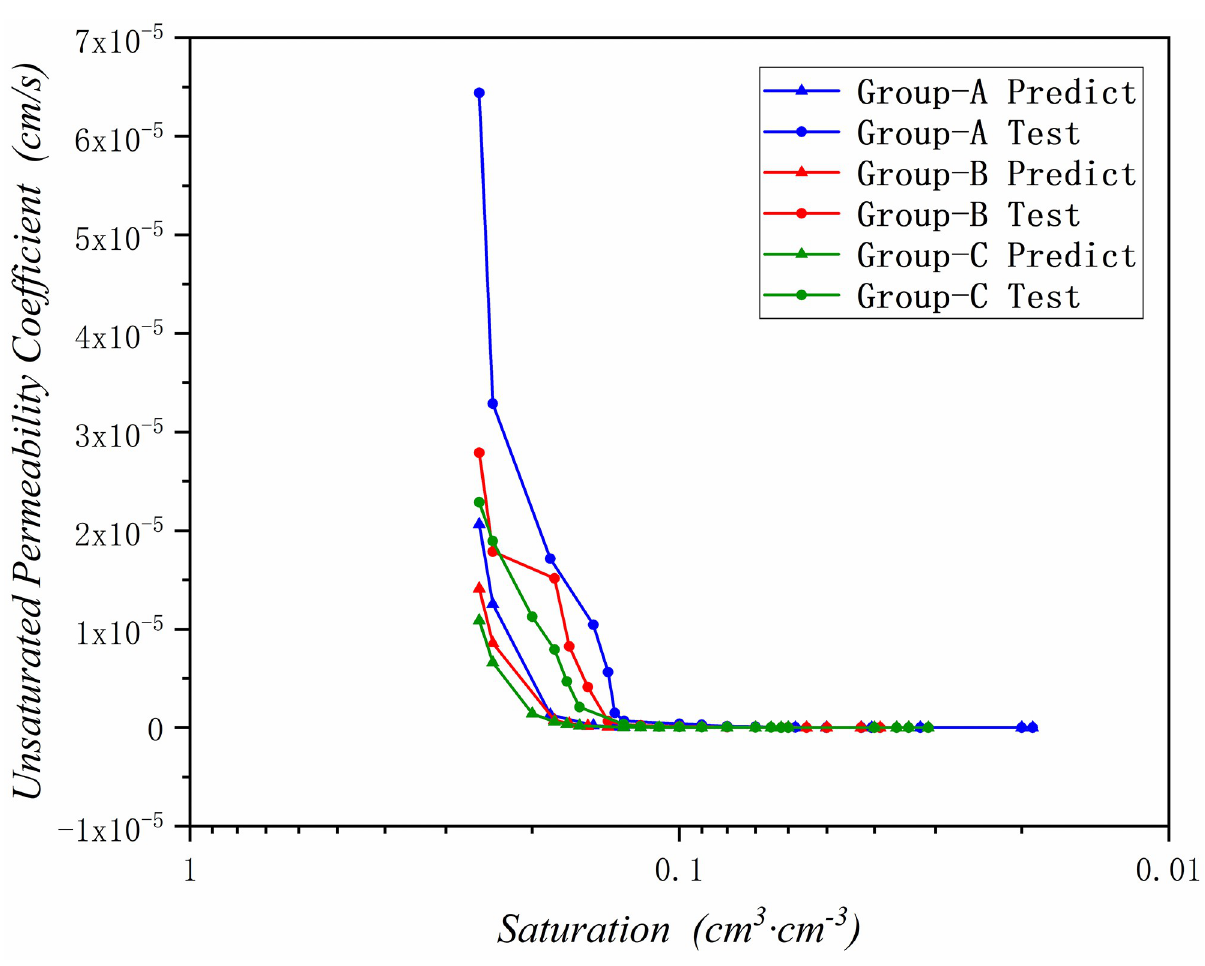
Fig 12. The predicted unsaturated permeability coefficient graph in Zone I(Jingbian).